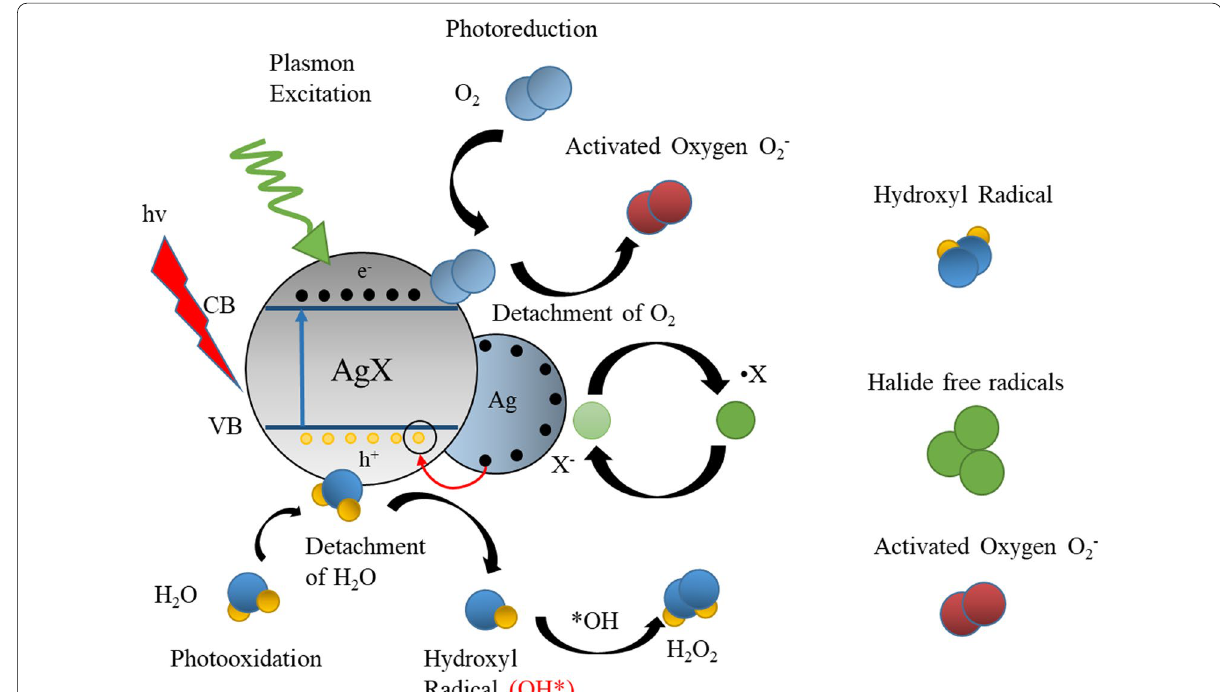
Fig. 1 The photocatalytic mechanism of AgX and AgNPs. The AgX as a semiconductor absorbs photons under light irradiation, which generates photoelectron–hole pairs when the energy is greater than the bandgap. The photocarriers migrate to the surface under the action of the electric field or by diffusion motion. The electrons and holes migrate to the surface of the catalyst and react with the adsorbed material on the surface of the catalyst, respectively. Meanwhile, Ag as a conductor can promote electron transfer to the holes on AgX